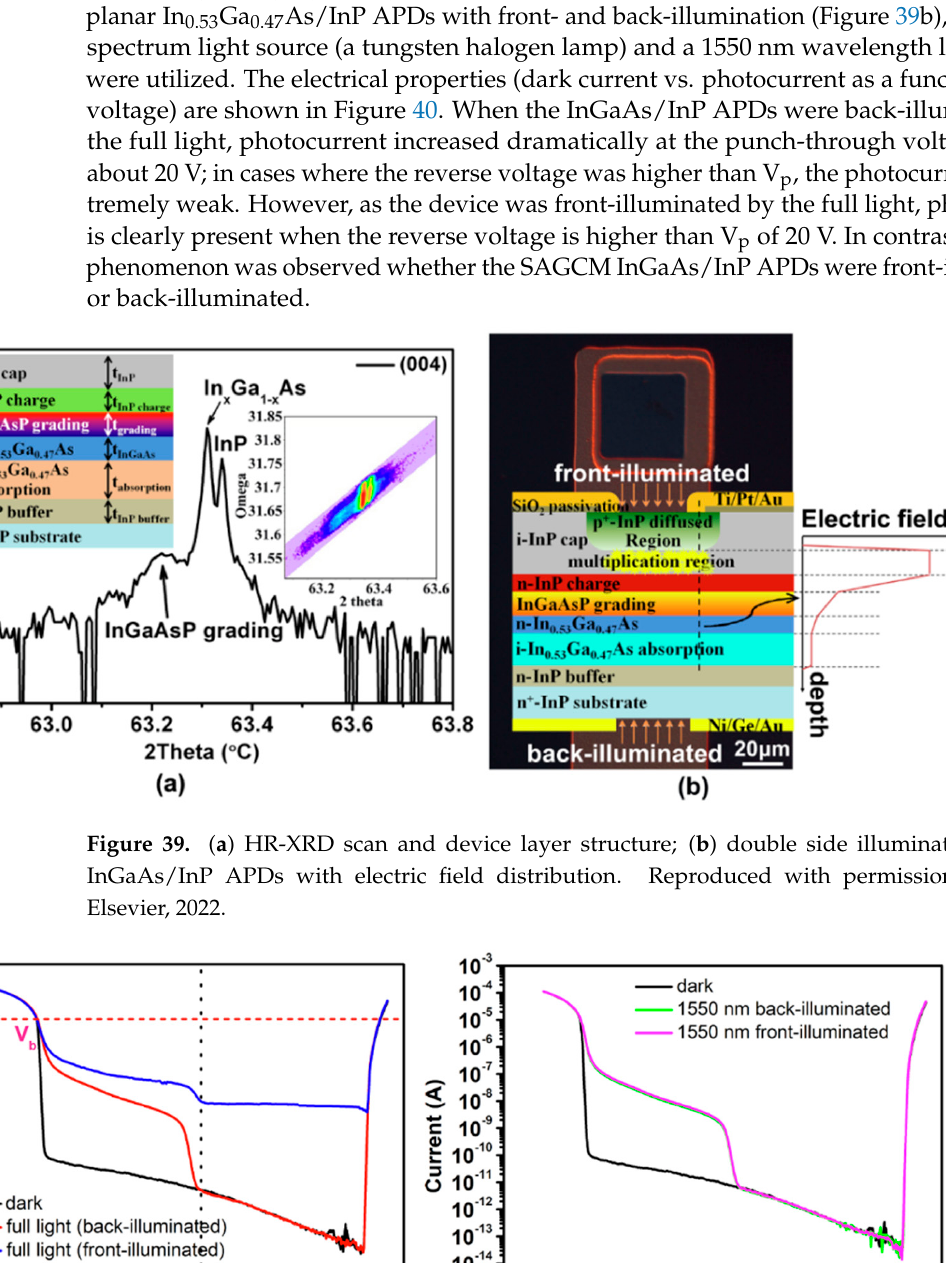
Figure 41. Schematic diagram and SEM image for the optimized back-illuminated planar In- GaAs/InP APD Junyang Zhang et al. [95] demonstrated the experimental results for the planar In- GaAs/InP-based APDs with different FGR structures. Firstly, the MOCVD system was used to grow the SAGCM InGaAs/InP structure on the 2-inch n+-InP substrate (Figure 42a), which is also passivated by the SiN x and it also has the FGR structure (Figure 42b). After the device is fabricated, the diameter of the FGR region and distance between the diffused p+ region and the FGR region are represented as the L1 and L2, respectively. After careful design, the optimum values for L1 and L2 are 12 μ m and 8 μ m, respec- tively(Figure 42c–e). Figure 43a shows the typical I-V characteristics under dark and light illumination for the optimized planar InGaAs/InP-based APDs; both V pt and V br can be extracted. The relationship between the Vbr and L1, L2 is plotted in Figure 43b, and it is p + -InP diffused region p +